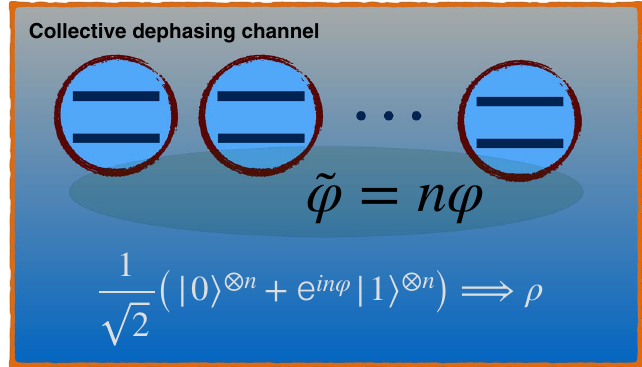
Figure 8. Illustration of an n -qubit register collectively subject to white noise under the action of a common depolarizing channel. This channel turns an initial pure state η 1 I ρ dep η ψ 0 ψ 0 − d d . This figure was created using Keynote, version 10.3.9 (7029.9.8), URL: https:// d = | �� | + × apps. apple. com/ it/ app/ keyno te/ id409 183694? mt= 12.